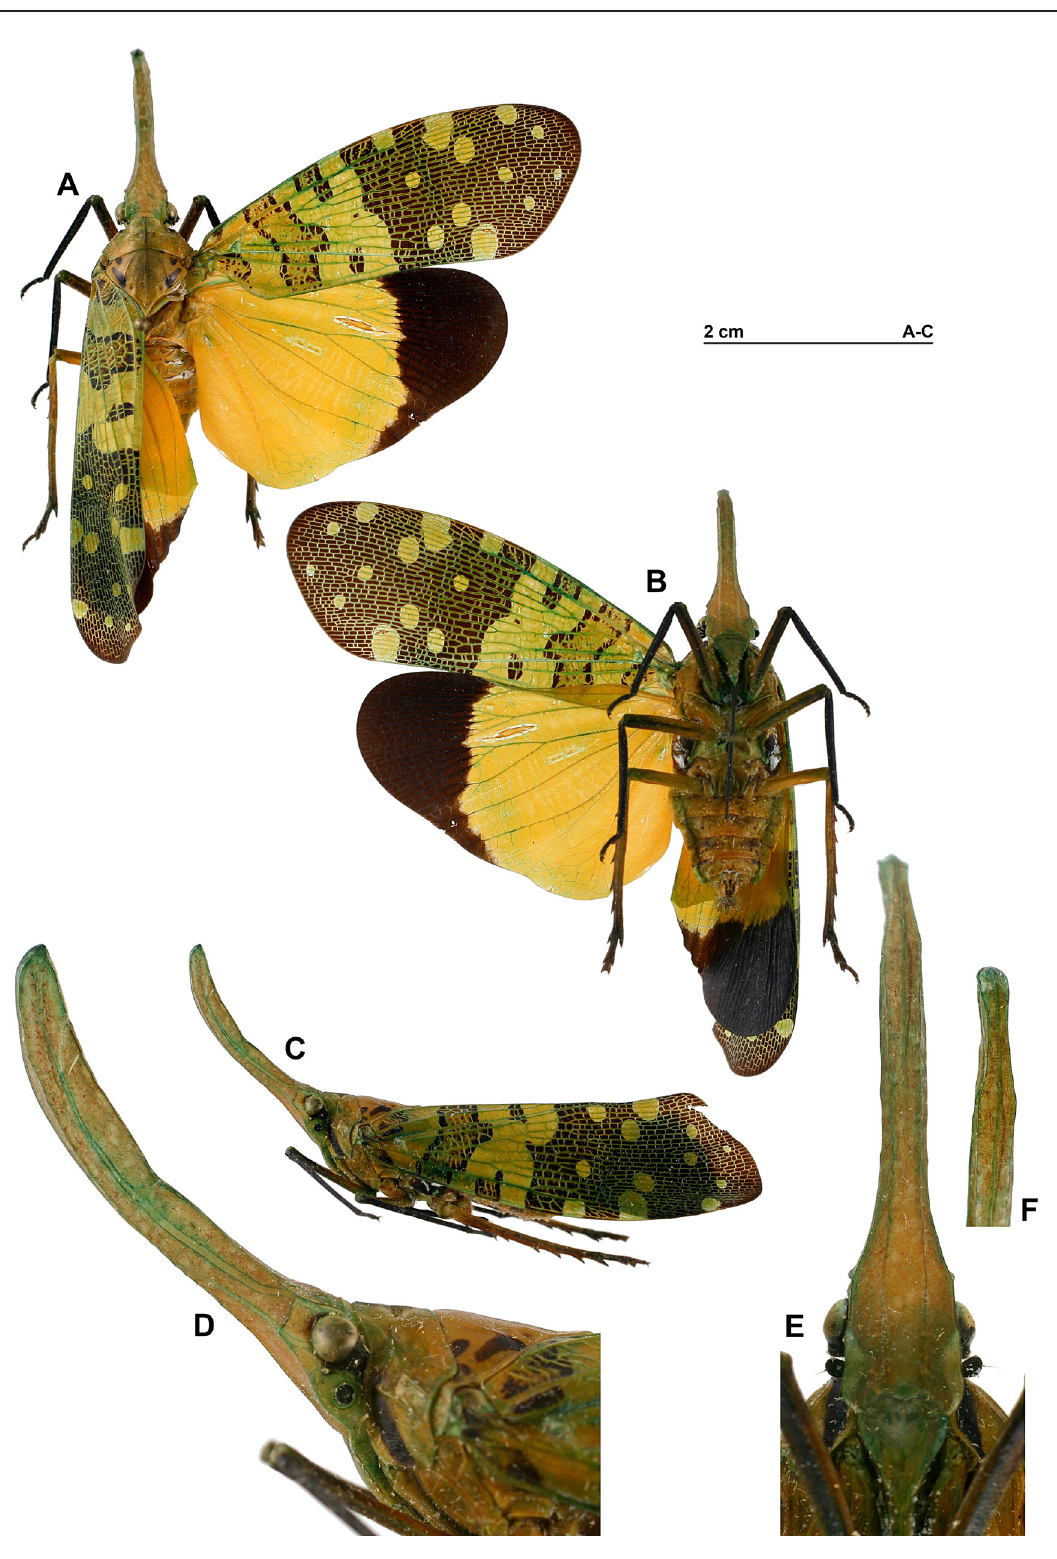
Fig. 12. Pyrops viridirostris (Westwood, 1848), ♀, Thailand, Kanchanaburi Prov., Say Yok N.P., 4–5 Jun. 2003 (RBINS). A . Habitus, dorsal view. B . Habitus, ventral view. C . Habitus, lateral view. D . Head and thorax, lateral view. E . Head, perpendicular view of frons. F . Apex of cephalic process, anteroventral view. D–F = not to